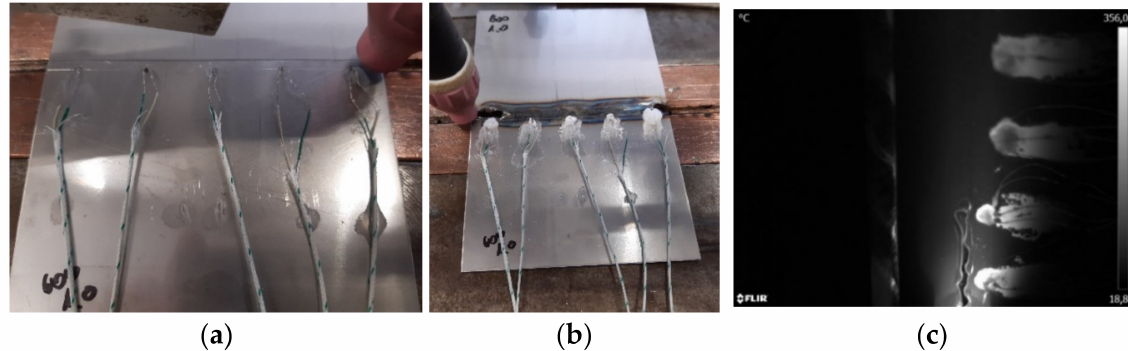
Figure 2. Thermocouples installed on test sample ( a ) before welding and ( b ) after welding, and ( c ) an IR image of hot- covered